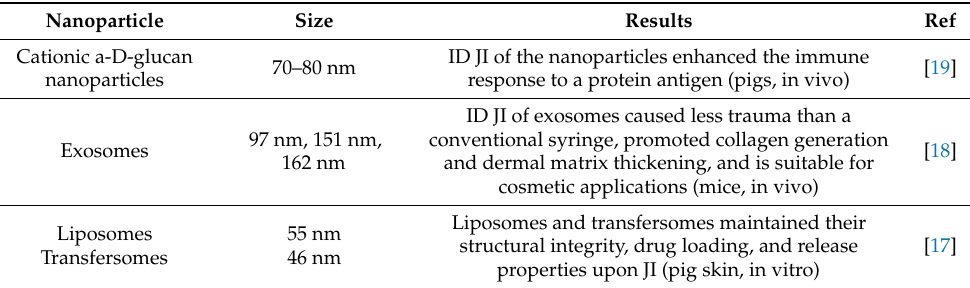
Table 1. Research works reporting the combined use of nanoparticles with needle-free liquid jet injectors for drug administration purposes and/or to study the impact of formulation and device parameters on the injection results. Abbreviations: ID, intradermal; JI, jet injection. Nanoparticle